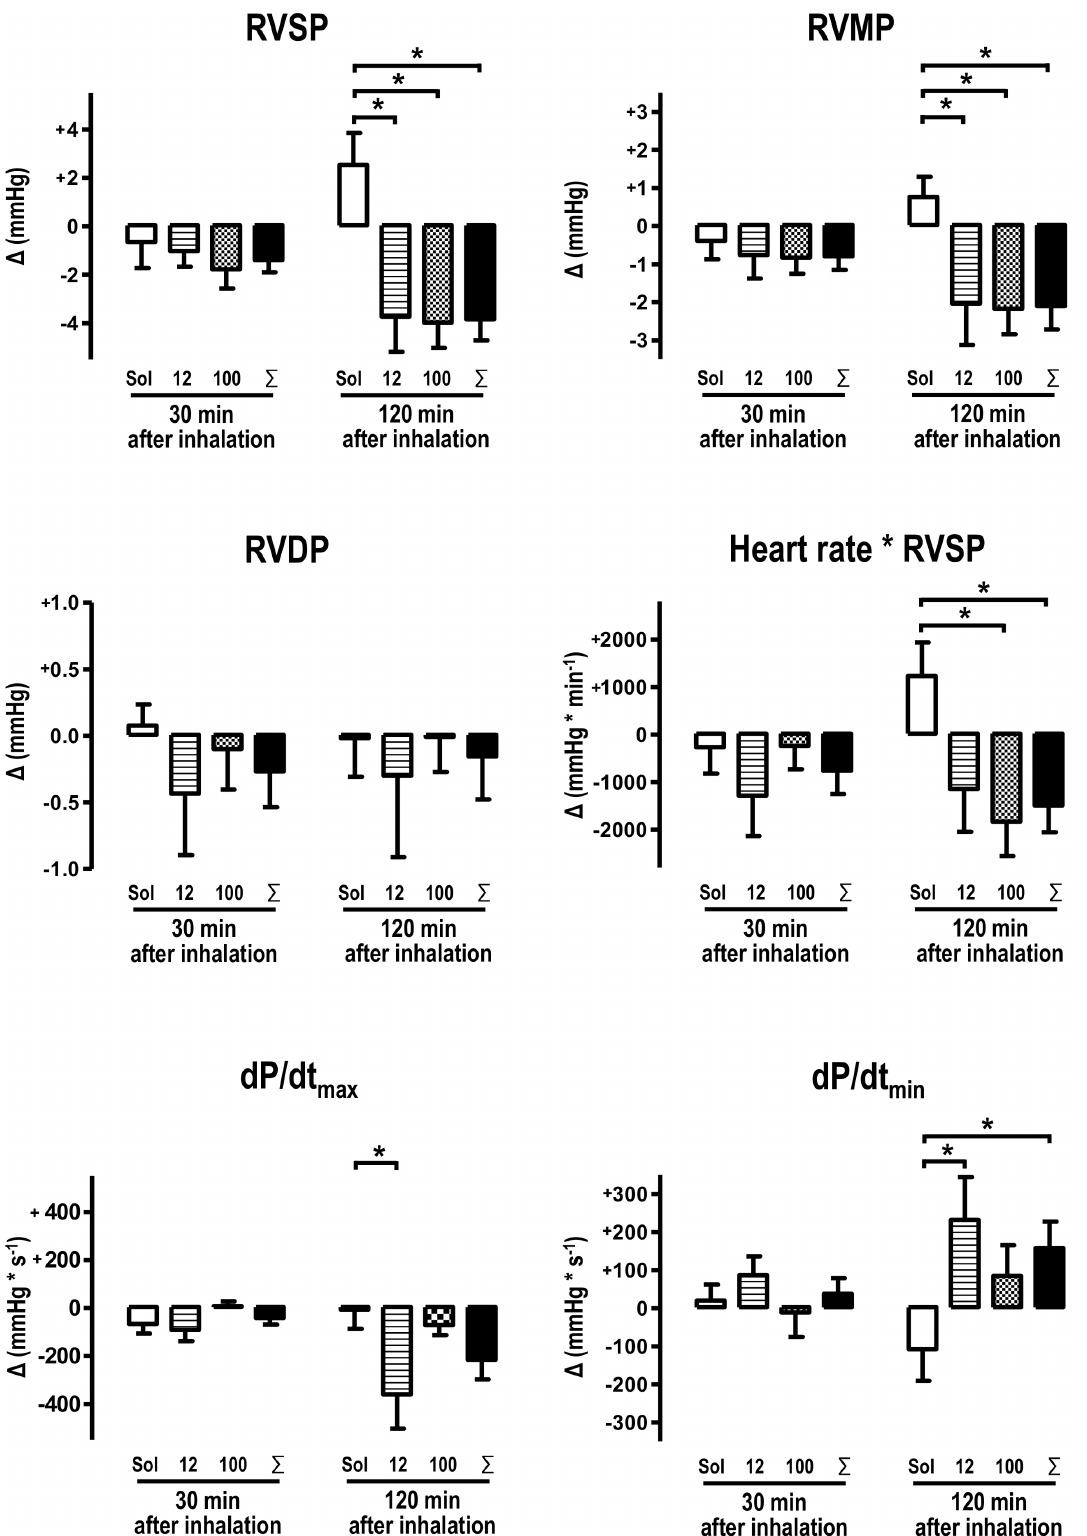
Figure 1. NS1619 reduces right ventricular pressure. Inhalation of 12 m M and 100 m M NS1619 significantly attenuates monocrotaline-induced right ventricular hypertension in comparison to solvent-treated animals 120 minutes after inhalation. In detail, right ventricular systolic pressure (RVSP) and right ventricular mean pressure (RVMP) were reduced in both NS1619 groups and consecutively in the cumulative g NS1619 versus solvent calculation. As a result of the reduced RVSP, the approximated right ventricular work, which is characterized by the product of heart rate and RVSP is attenuated in the 100 m M and the g NS1619 group, too. Right ventricular maximum velocity of the pressure slope (dP/dt max ) were